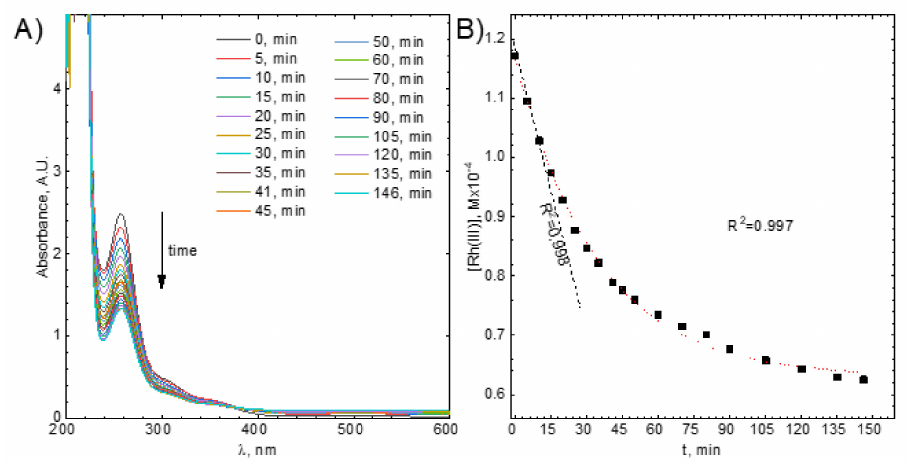
Figure 4. ( A ) UV-Vis spectra evolution vs. time, ( B ) example of the kinetic curve with the fitted integral form of the kinetic equation (dotted line) and straight line, the dashed one, showing the initial reaction rate. Experimental conditions: [C] = 1 g, [Rh(III)] ≈ 1.1 × 10 − 4 M, T = 50 ◦ C, V = 1200